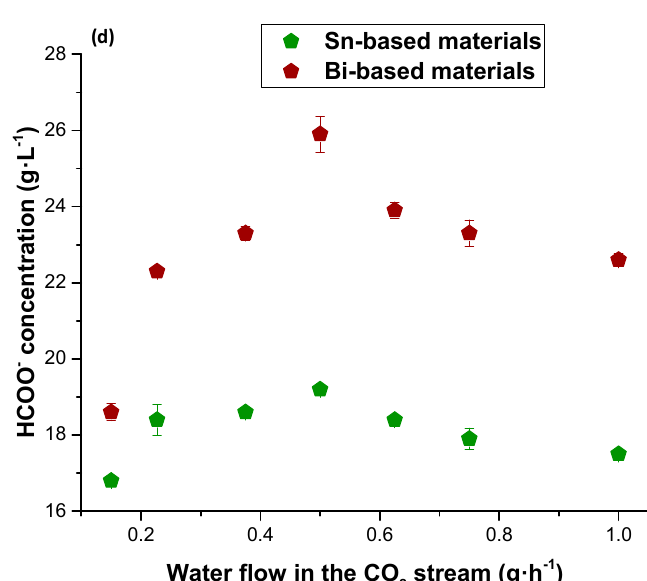
Figure4. InfluenceofwaterflowintheCO 2 streamon( a )Faradaice ffi ciencyforHCOO − (%), ( b )HCOO −